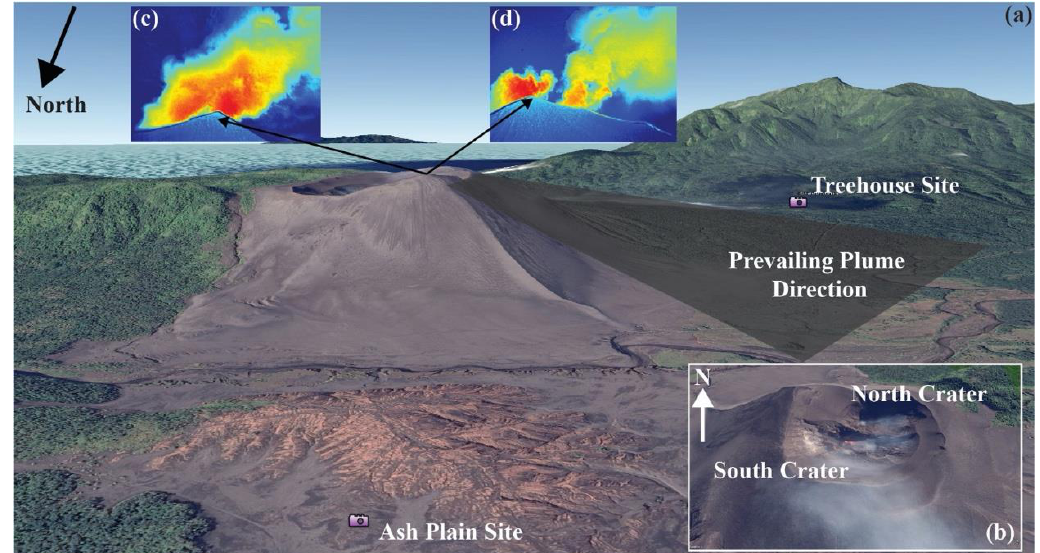
Figure 2. ( a ) An elevation-based perspective of the low summit of Yasur volcano, along with measurement positions and the prevailing plume transport direction, with the inset ( b ) showing a close-up of the summit crater. ( c ) A typical view of the plume, with red colours representing higher concentrations of SO 2 , showing clear mixing between plumes from different vents. ( d ) An example of where it was possible to differentiate between emissions from both craters. Imagery is from Google Earth ® .